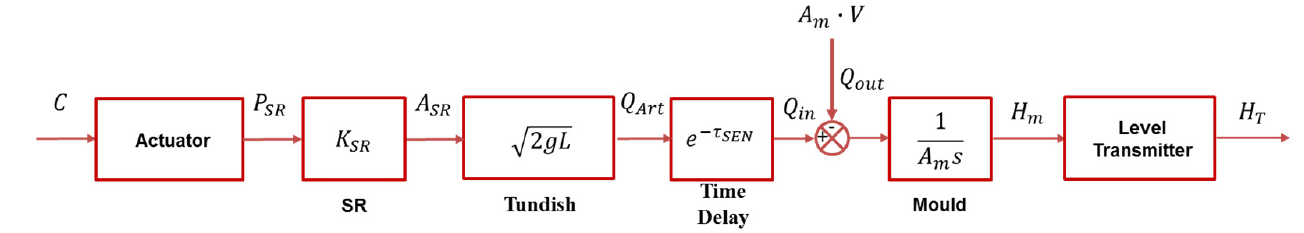
Figure 1. Simple plant